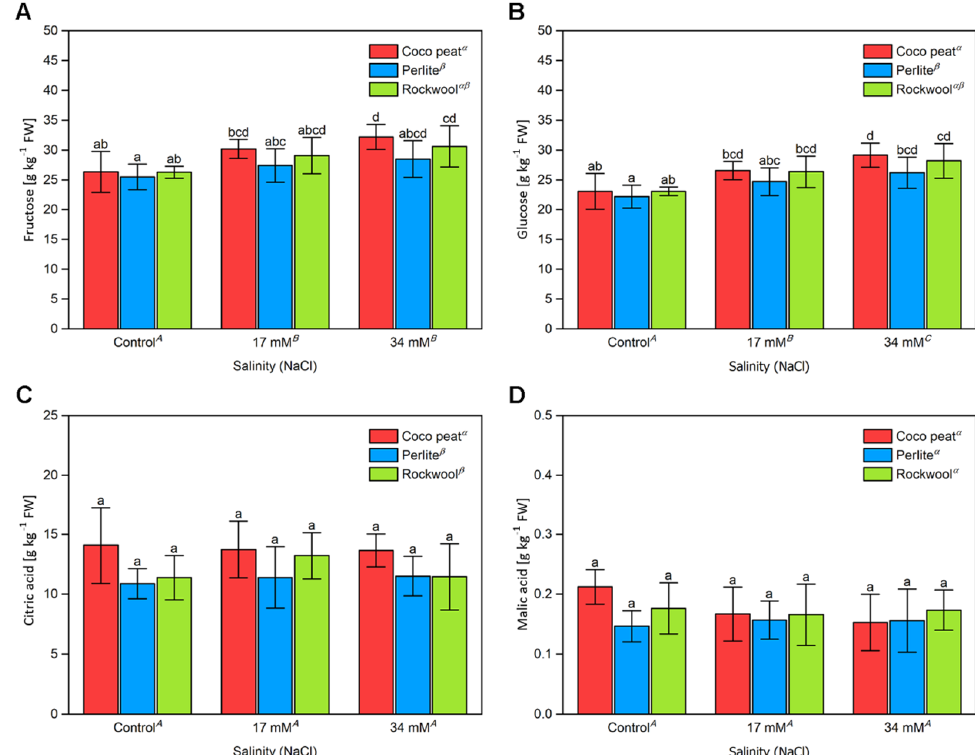
Figure 4. The sugar content and acidity of cherry tomato fruit grown in different substrates with increasing salinity. The fructose ( A ), glucose ( B ), citric acid ( C ), and malic acid ( D ) content of cherry tomato fruits from two harvests between the 10 October and 17 October 2017 grown in coco peat, perlite and Rockwool with increasing salinity by sodium chloride in the nutrient solution. The error bars represent the SD. Upper-case letters compare the salinity treatments, Greek letters compare different substrates, lower-case letters within the graph compare single mean values of the treatments. The raw data are available in Supplementary File S1.